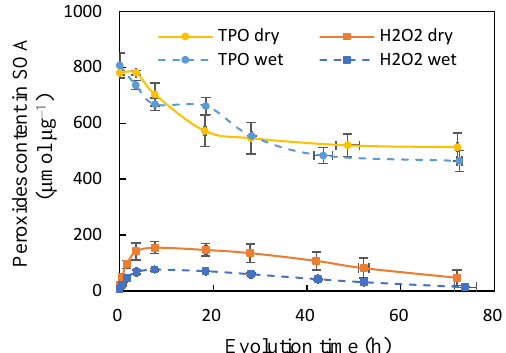
Figure 2. Decomposition/hydrolysis of organic peroxides in the aqueous phase. C t /C 0 is the ratio of peroxides’ concentration at time = t h to peroxides concentration at time = 0h. Lines are expo- nential fits for HMHP, PFA, and PAA. The decay rate constants of HMHP, PFA, and PAA are 0.09, 1.06, and 0.64h − 1 , respectively. The data represent the mean ± SD of three